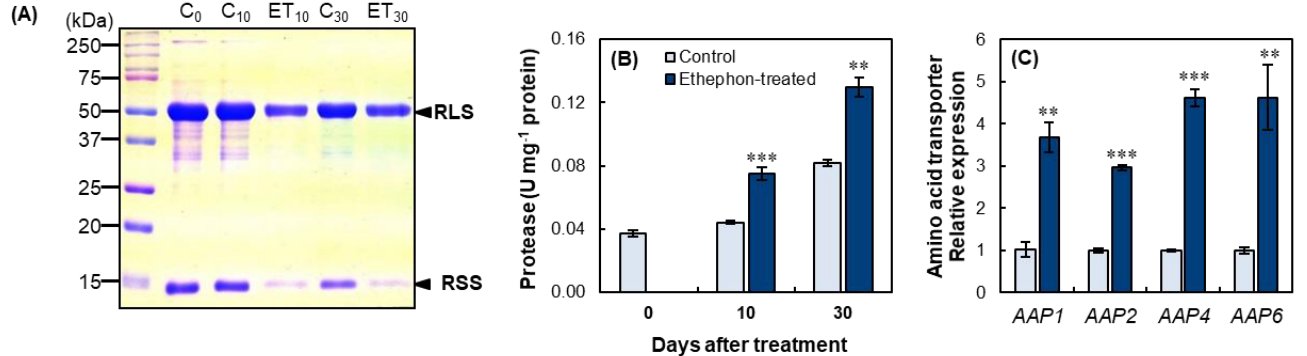
Figure 4. Long–term effects of 100 ppm ethephon application on protein degradation and amino acid transport. ( A ) SDS – PAGE protein profiles, ( B ) protease activity, and ( C ) amino acid transporters gene expression in mature leaves of the control and ethephon − treated plants before the ethephon application (day 0), at the end of ethephon application for 10 days (day 10), and an additional 20 days after the treatment (day 30). Each lane was loaded with 25 µg of soluble protein. Molecular mass makers (kDa) are listed on the left or right side of the gel. C 0 , C 10 , and C 30 indicate the control plants at day 0, day 10, and day 30, respectively, whereas ET 10 and ET 30 indicate the ethephon-treated plants at day 10 and day 30, respectively. Data are presented as mean ± SE ( n = 3). The qRT – PCR was performed in duplicate for each of the three independent biological samples. Significant differences between treatments are represented by ** p < 0.01; *** p < 0.001.